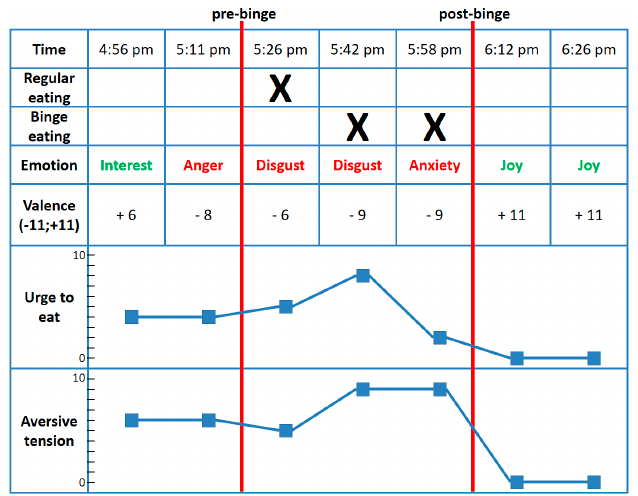
Figure 1. Affective dynamics and eating behavior of a single patient with bulimia nervosa (BN) before, during, and after a binge eating episode. Valence constitutes the intensity of emotions rated on an 11-point Likert scale from 0–11, whereas the intensity rating was multiplied by − 1 in the case of negative emotions; therefore, valence scores range from − 11 to +11. Urge to eat and aversive tension were assessed on an 11-point Likert scale from 0–10, with higher values indicating a stronger urge to eat and stronger aversive tension, respectively.